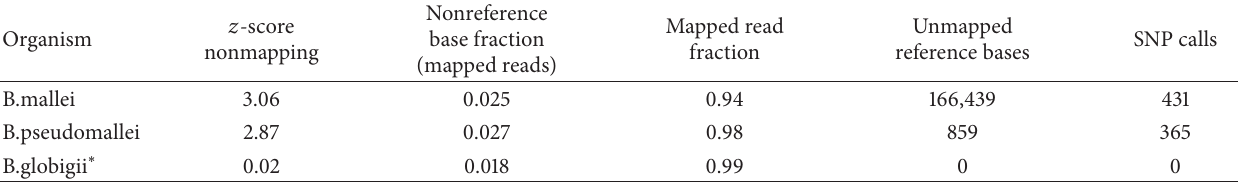
Table 2: Pipeline B alignment-based mapping statistics for threat agents and our Bg calibrant for comparison to nonalignment 𝑍 values. Nonreference 𝑧 -score Mapped read Organism base fraction nonmapping fraction reference (mapped reads)